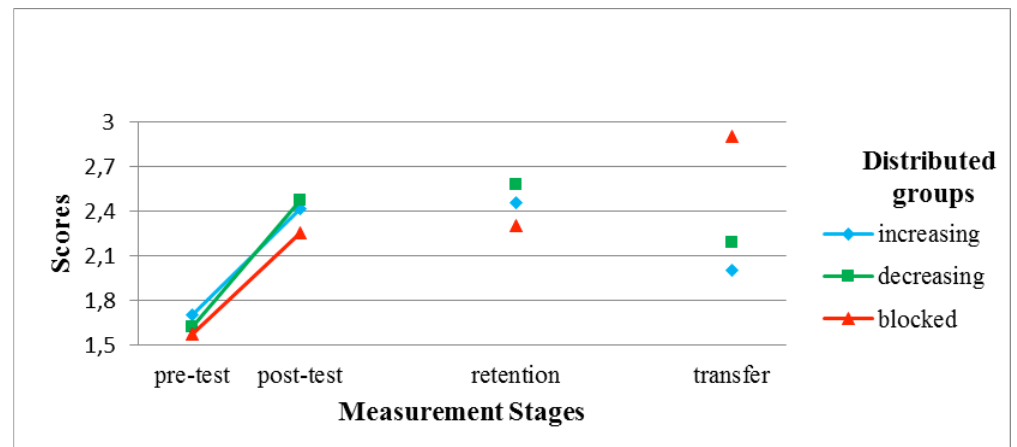
Figure 2. The mean of scores in various stages of measurement in distributed